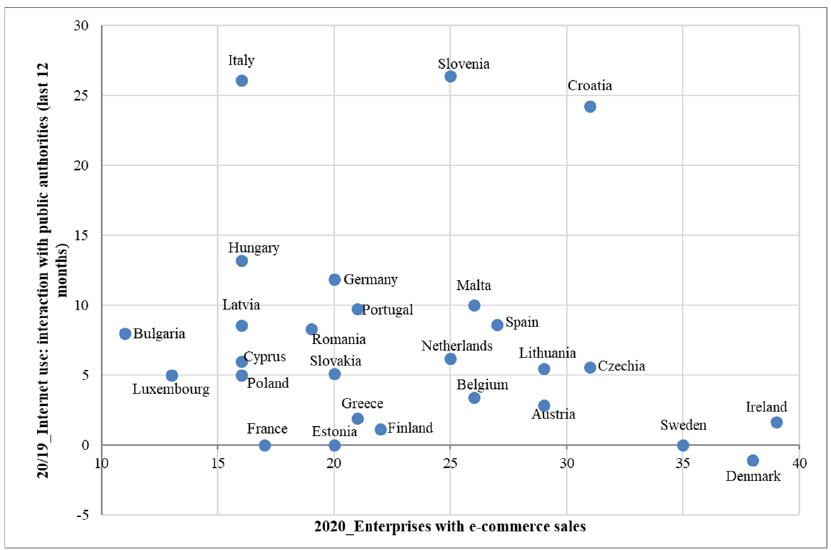
Figure 2. Enterprises with e-commerce sales vs. dynamic in internet usage based on interaction with public authorities in the 12 months across European countries in 2020 vs. 2019. Source data: own representation based on Eurostat data, 2020.